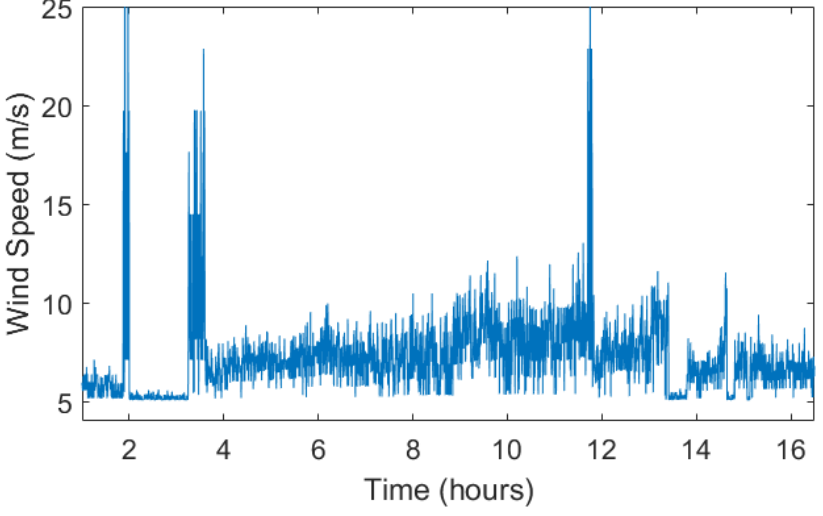
Figure 6. Example of variable wind speed profiles used in